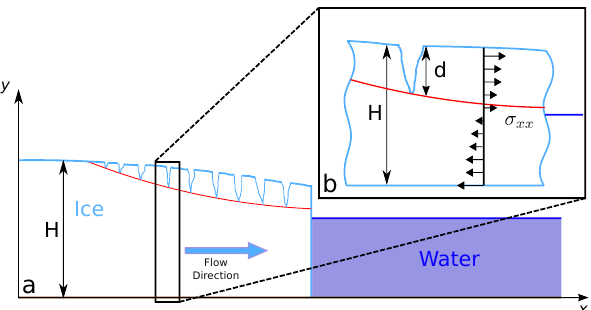
Figure 3. (a) Shape of a grounded glacier and (b) close-up of one crevasse. The red curve illustrates the contour of critical damage D = D c , for which we computed the along-flow component of the Cauchy stress tensor σ xx multiplied by the weight function, and integrated over the crevasse depth d